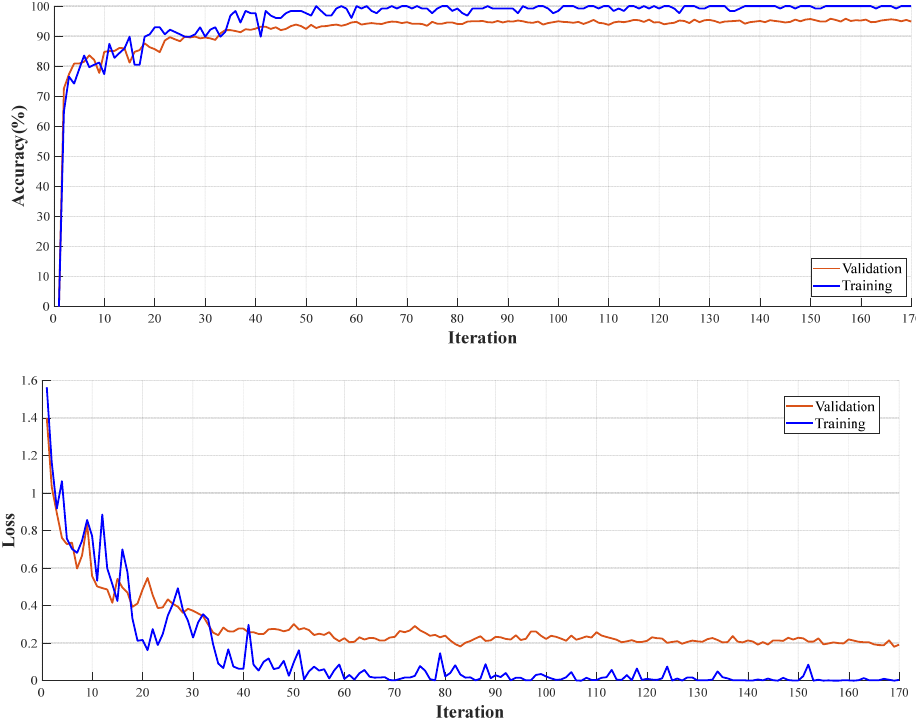
Figure 3. Training and validation curves of the DenseNet201 for Dataset I.